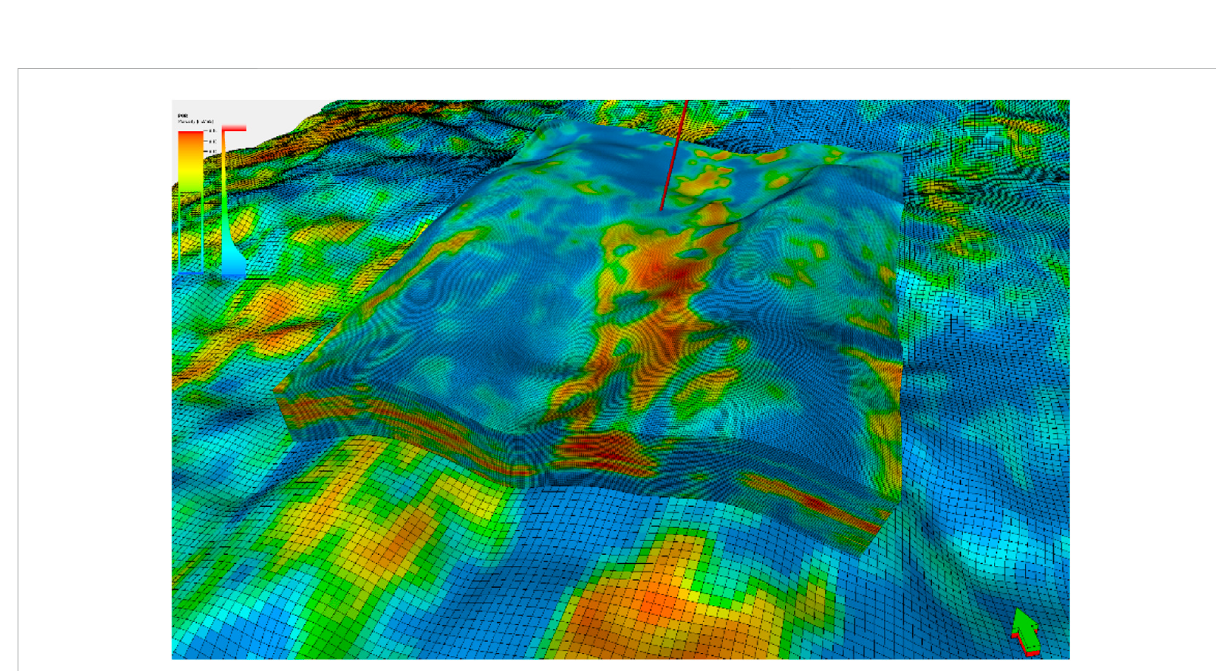
FIGURE 5 Comparison diagram of regional and platform